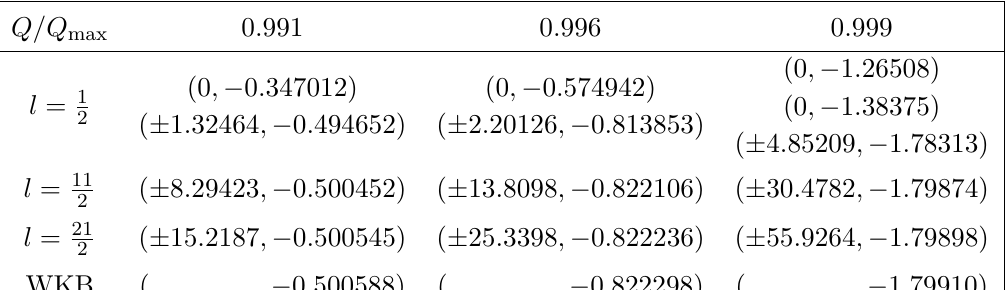
Table 1 . The low-lying QNMs !